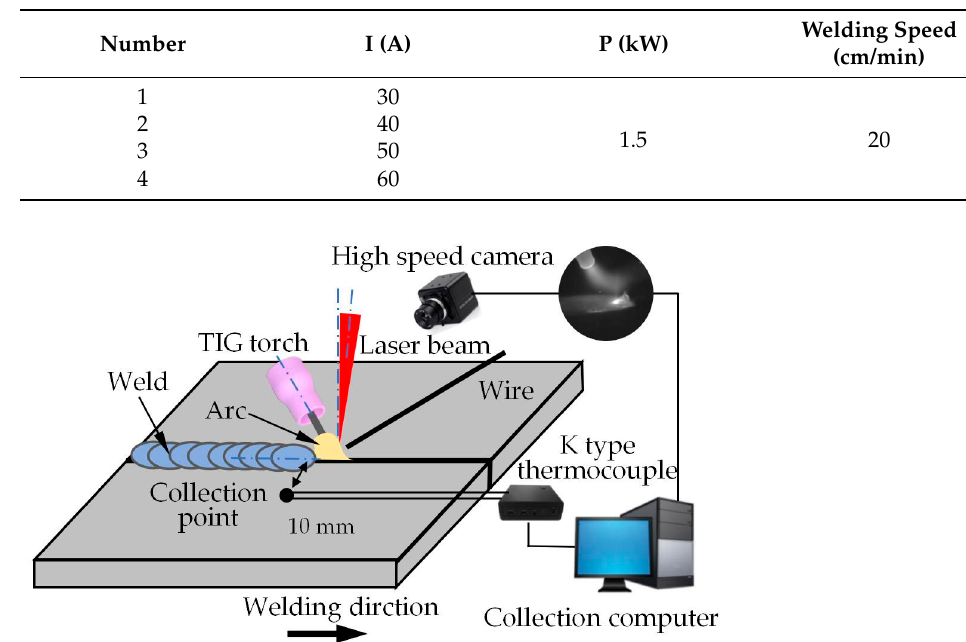
Table 2. Experiment parameters of welding.